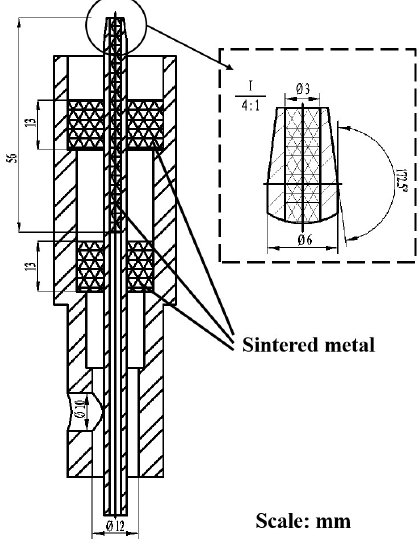
Figure 3. A schematic of the coflow burner.